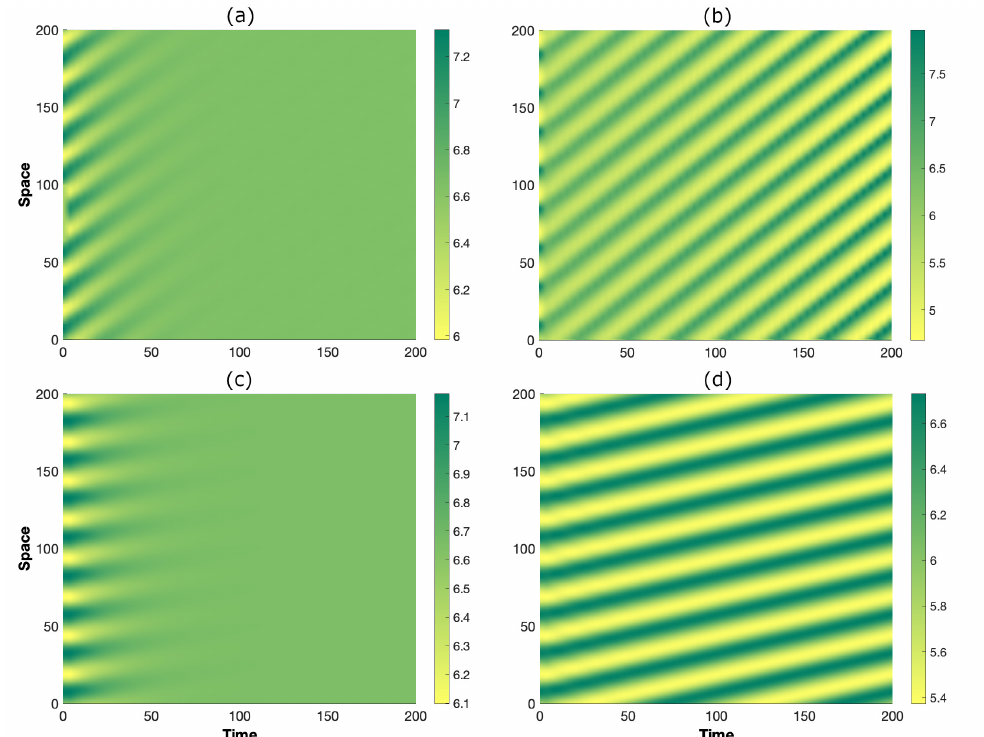
Figure 3. Spatio–temporal evolution obtained through the numerical integration of the governing system (1)–(3) in the configurations P 1 [panels ( a , c )] and P 2 [panels ( b , d )]. The results in the top row were obtained for ψ = 0.2 [panels ( a , b )], whereas those in the bottom row were obtained for ψ = 0.8 [panels ( c , d )]. The other parameters are as in Figure